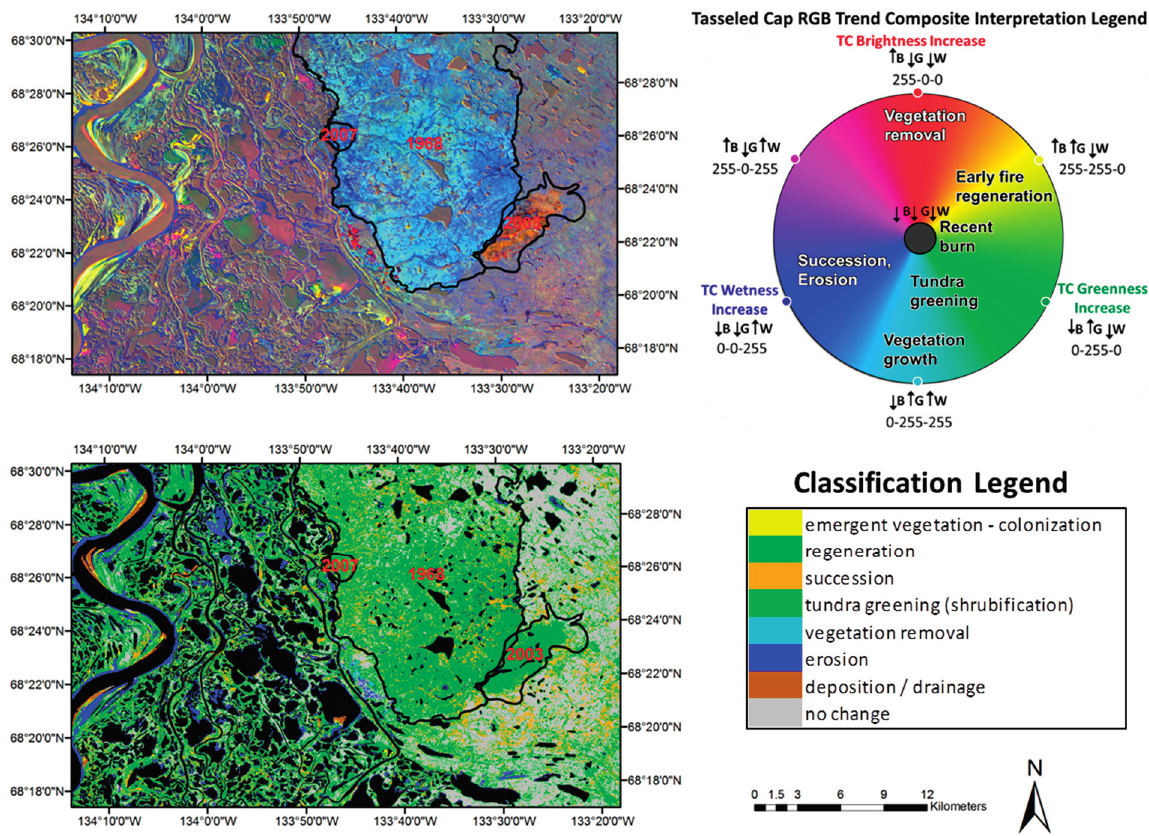
Figure 6. TCB, TCG, TCW displayed as R, G, B and interpretation legend (Fraser et al. , this issue [5]) and classified change process map for a region around